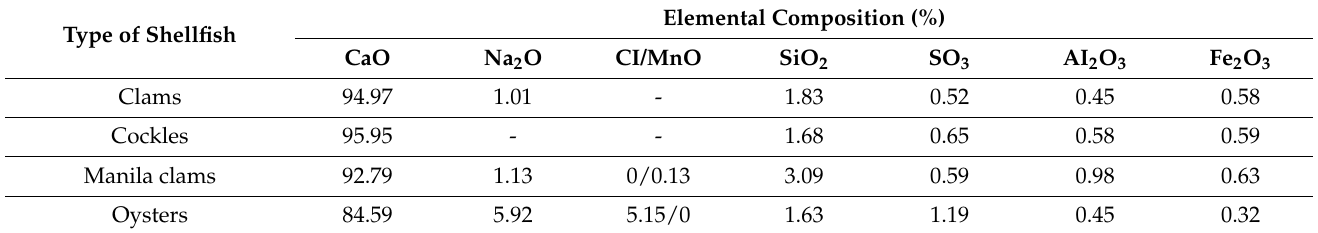
Table 4. Chemical compositions of different shellfish